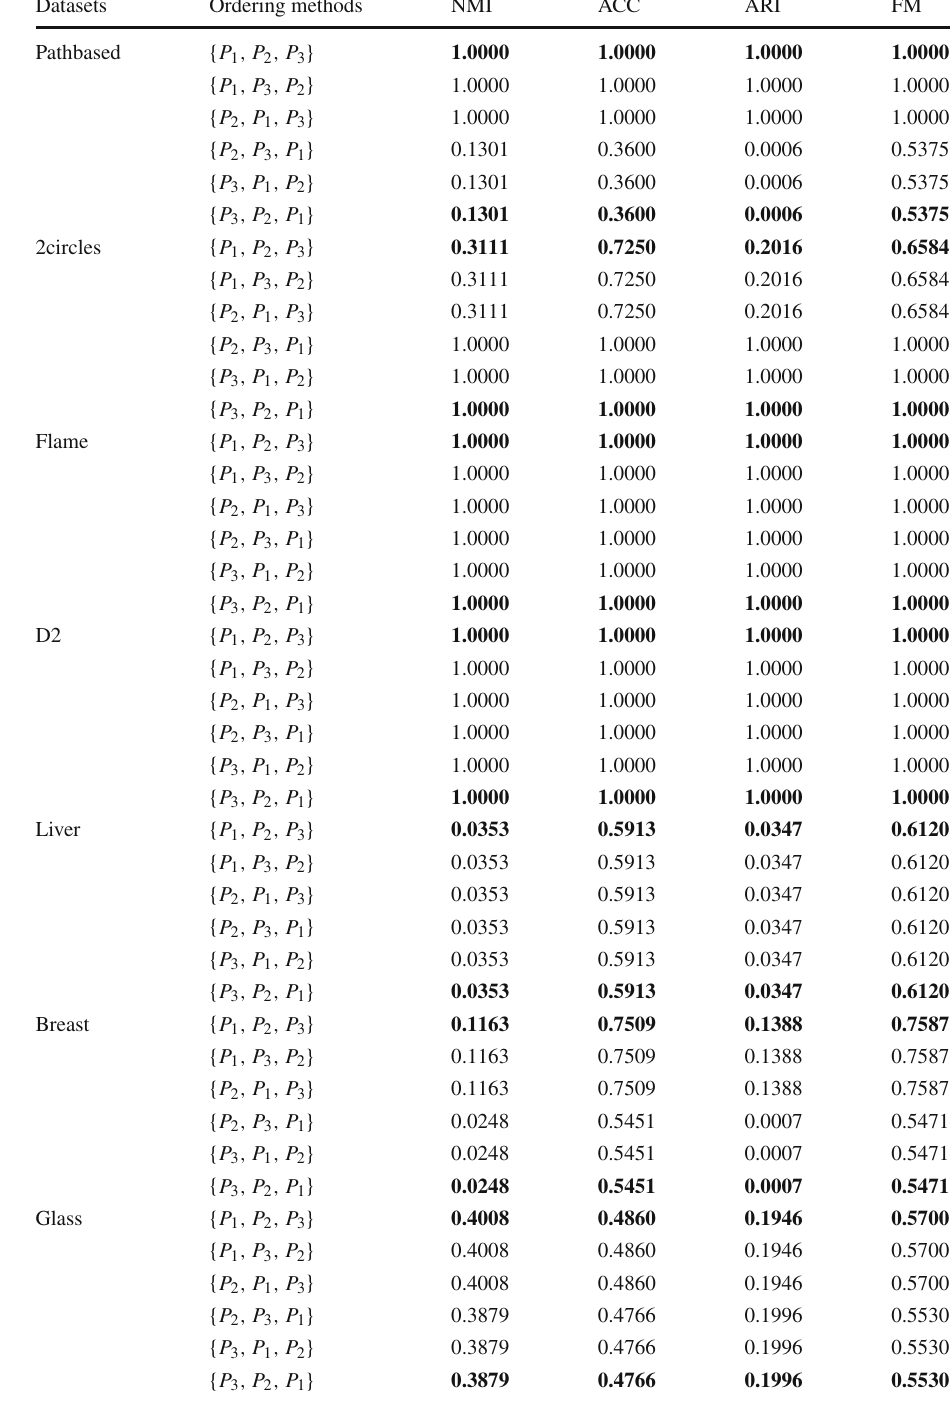
Table 6 The performance of multi-peak points intervals